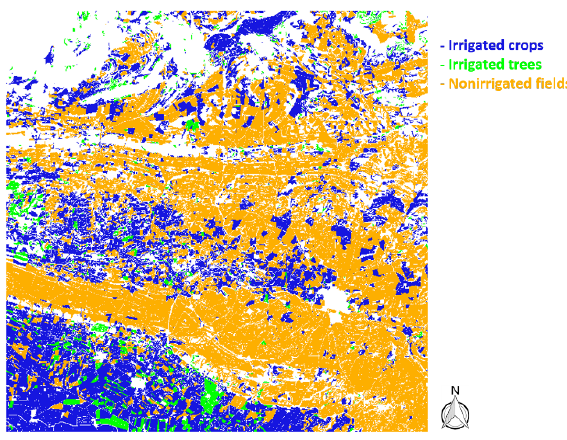
Figure 3. Mapping of irrigated